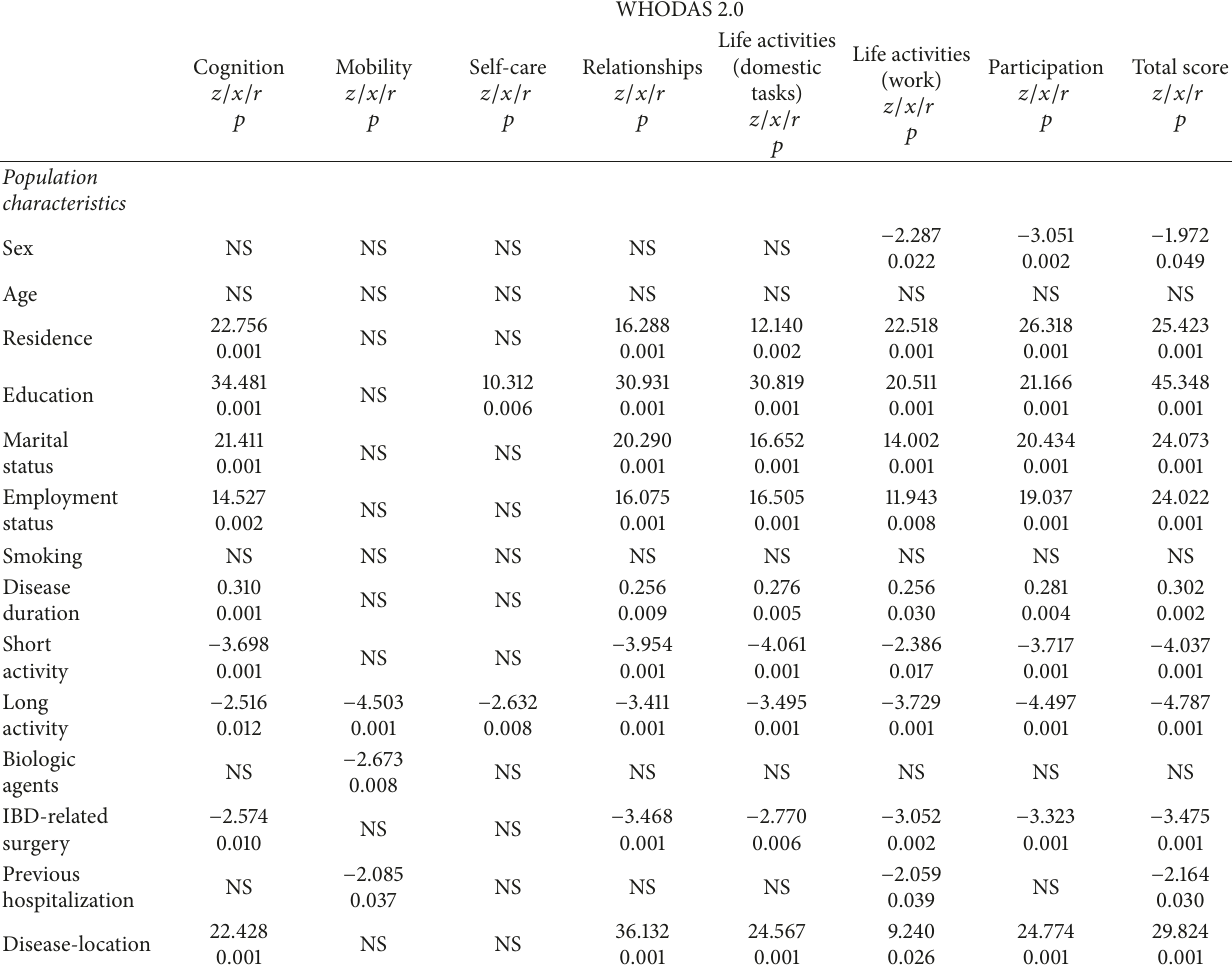
Table 4: Relationships between WHODAS 2.0 and population’s characteristics in patients with ulcerative